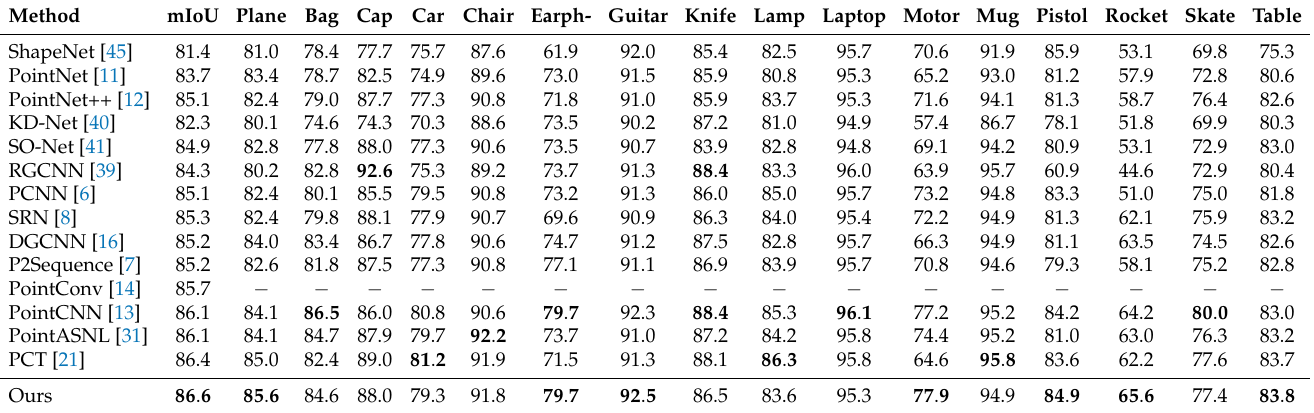
Table 2. Comparison of part segmentation